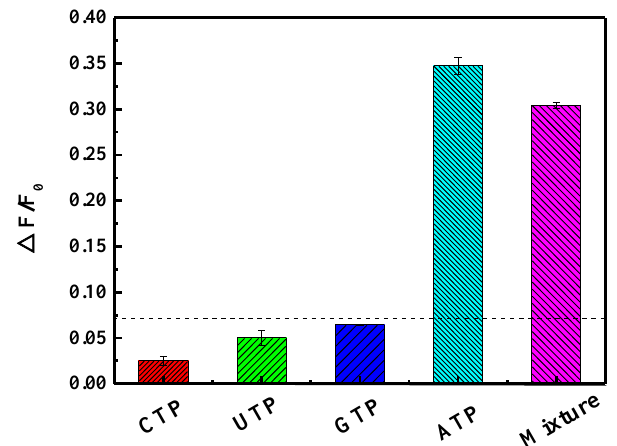
Figure 6. The selectivity of the DNA machine for the detection of ATP detection against GTP, CTP, and UTP. The mixture consists of ATP, CTP, UTP, and GTP, each in concentrations of 500 nM.